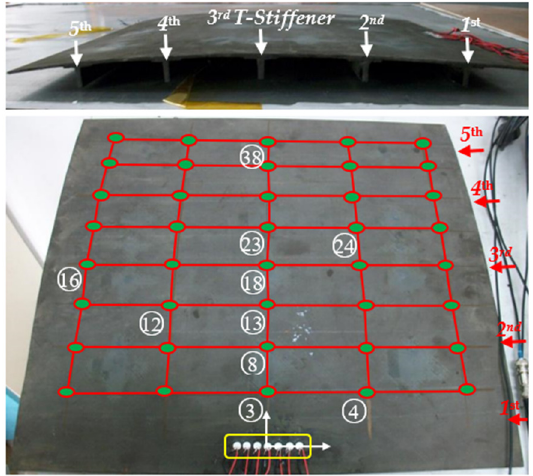
Figure 2. Impact location experiment on a curved composite panel with five stiffeners.